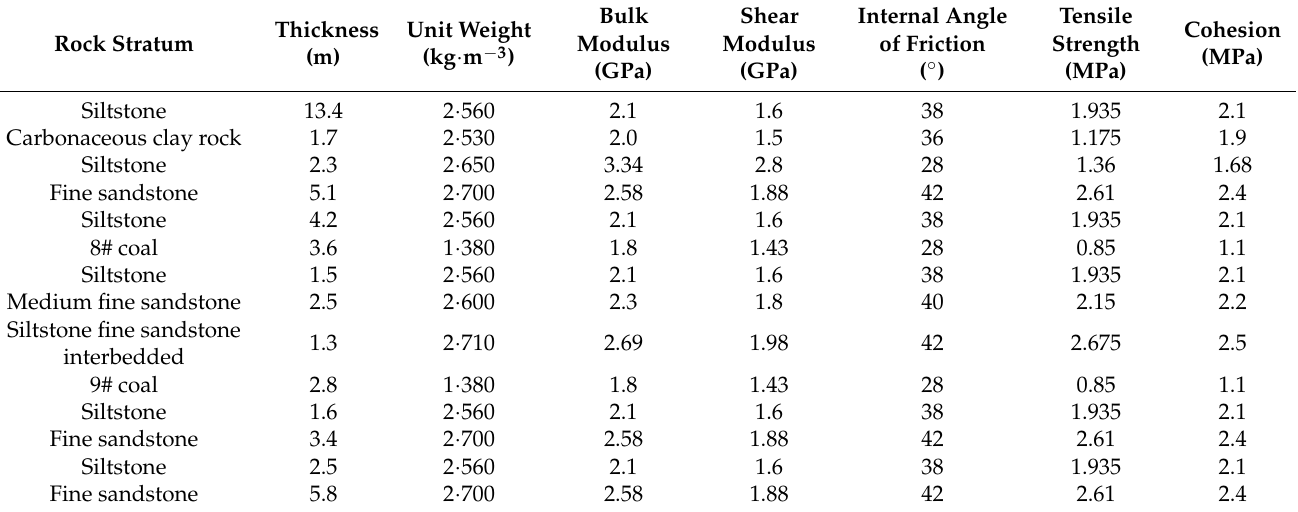
Table 2. Model physicomechanical parameters of strata in a certain